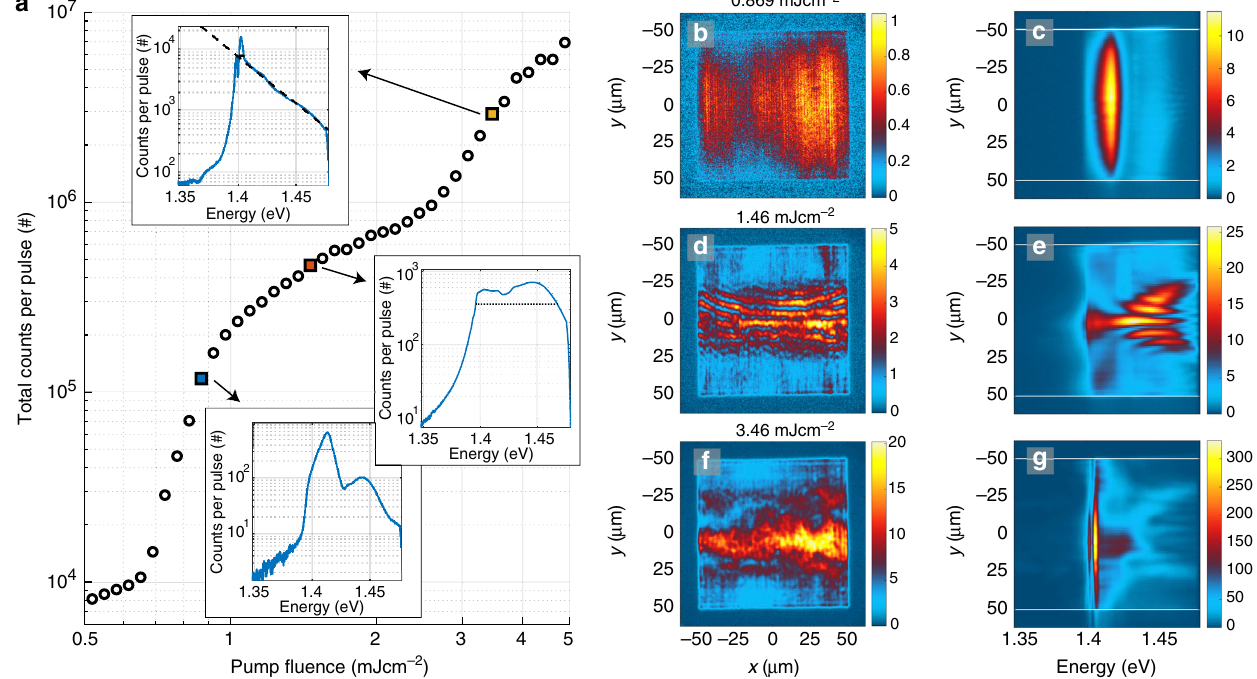
Fig. 2 Pump fl uence dependence, real space images and spectra. a Double-threshold curve of the pump fl uence dependence of the total luminescence intensity. Insets: Line spectra obtained by integrating over the real space spectra in the y -direction (between the white lines). The FWHM of the spectral peaks is marked in the insets: 12, 72, and 4.0 meV with increasing pump fl uence. The dashed line in the top inset is a fi t of the tail of the distribution to the Maxwell – Boltzmann distribution which gives a temperature of 313 ± 2 K (95% con fi dence bounds). b – g Left column: Real space images of the plasmonic lattice. Right column: Spectral information of the luminescence as a function of y -position. The pump fl uence is b , c 0.87 mJ cm − 2 , d , e 1.5 mJ cm − 2 , and f , g 3.5 mJ cm − 2 . The wave fronts in d , e arise from standing waves related to the momentum of the modes, for more information see Supplementary Fig. 1 and Note 1. The real space images are recorded for single pump pulses but the corresponding spectra are integrated over 500 ( c , e ) and 70 pulses ( g ). The results for the full range of pump fl uences are presented in Supplementary Movie